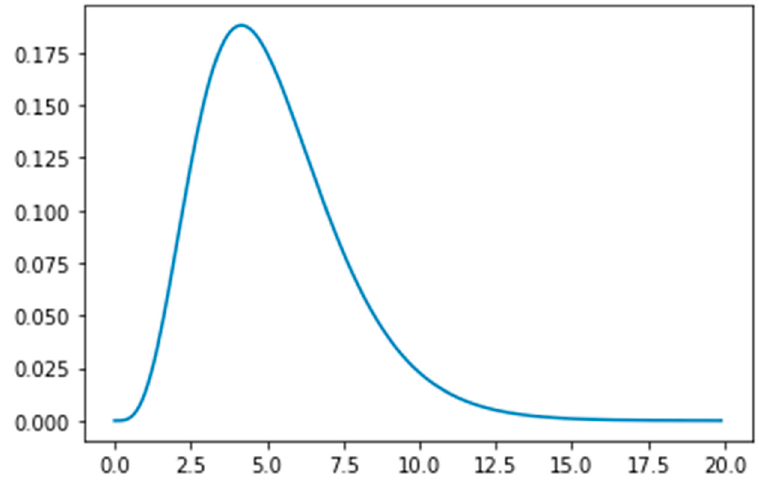
Figure 2. The Erlang distribution with parameters k = 5 and λ = 5/5.2 = 0.96, showing the time (in days) an exposed person spends in incubation period.